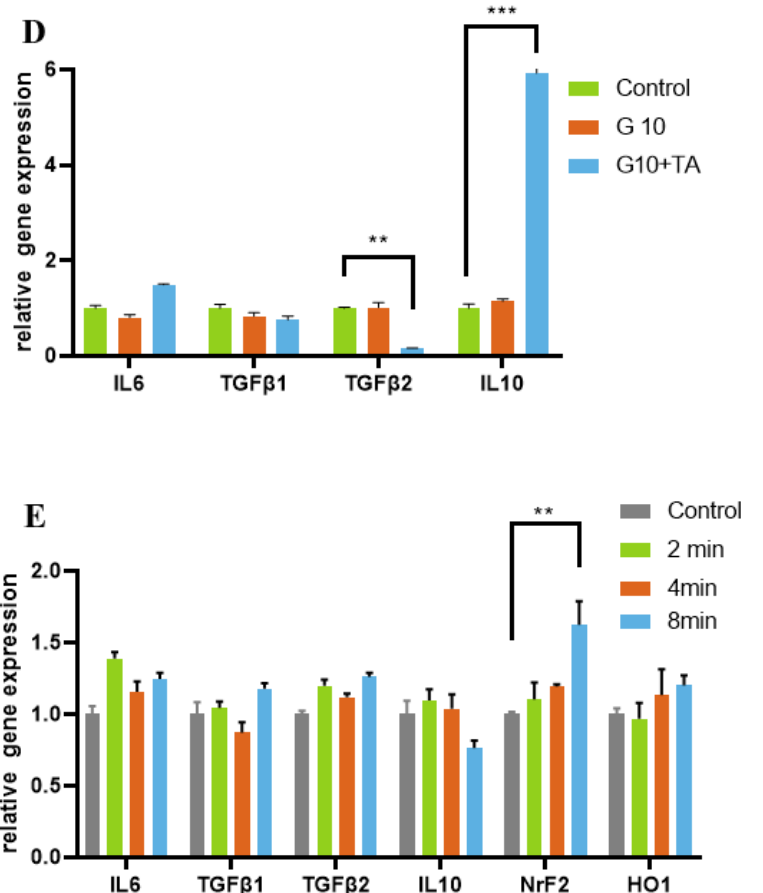
Figure 4. Assessment of the in vitro cytocompatibility of the GelMA + TA hydrogels. Representative bright field and live-dead images of HRPE cells that were seeded on tissue culture plates in complete medium and GelMA + TA leaching medium (10%, 20% w / v load with or without 1 mg TA) obtained on Days 1, 3, and 5 ( A ) and on the surface of the GelMA + TA hydrogel after 1 day of seeding ( B ) are shown. ( C ) The effect of GelMA + TA leaching medium on cell migration was determined using wound-healing assays. ( D ) qRT-PCR analysis of the relative mRNA expression levels of IL6, TGF β -1, TGF- β 2, and IL-10 mRNA in HRPE after culture in complete medium and in 10% GelMA ± TA leaching medium for 2 days. ( E ) HRPE cells were exposed to 405 nm light for the indicated times (2, 4, and 8 min), and IL6, TGF β -1, TGF- β 2, IL-10, Nrf2, and HO-1 mRNA expression was assayed by qRT-PCR. Scale bar: 100 µ m. (** p < 0.01, *** p < 0.001)